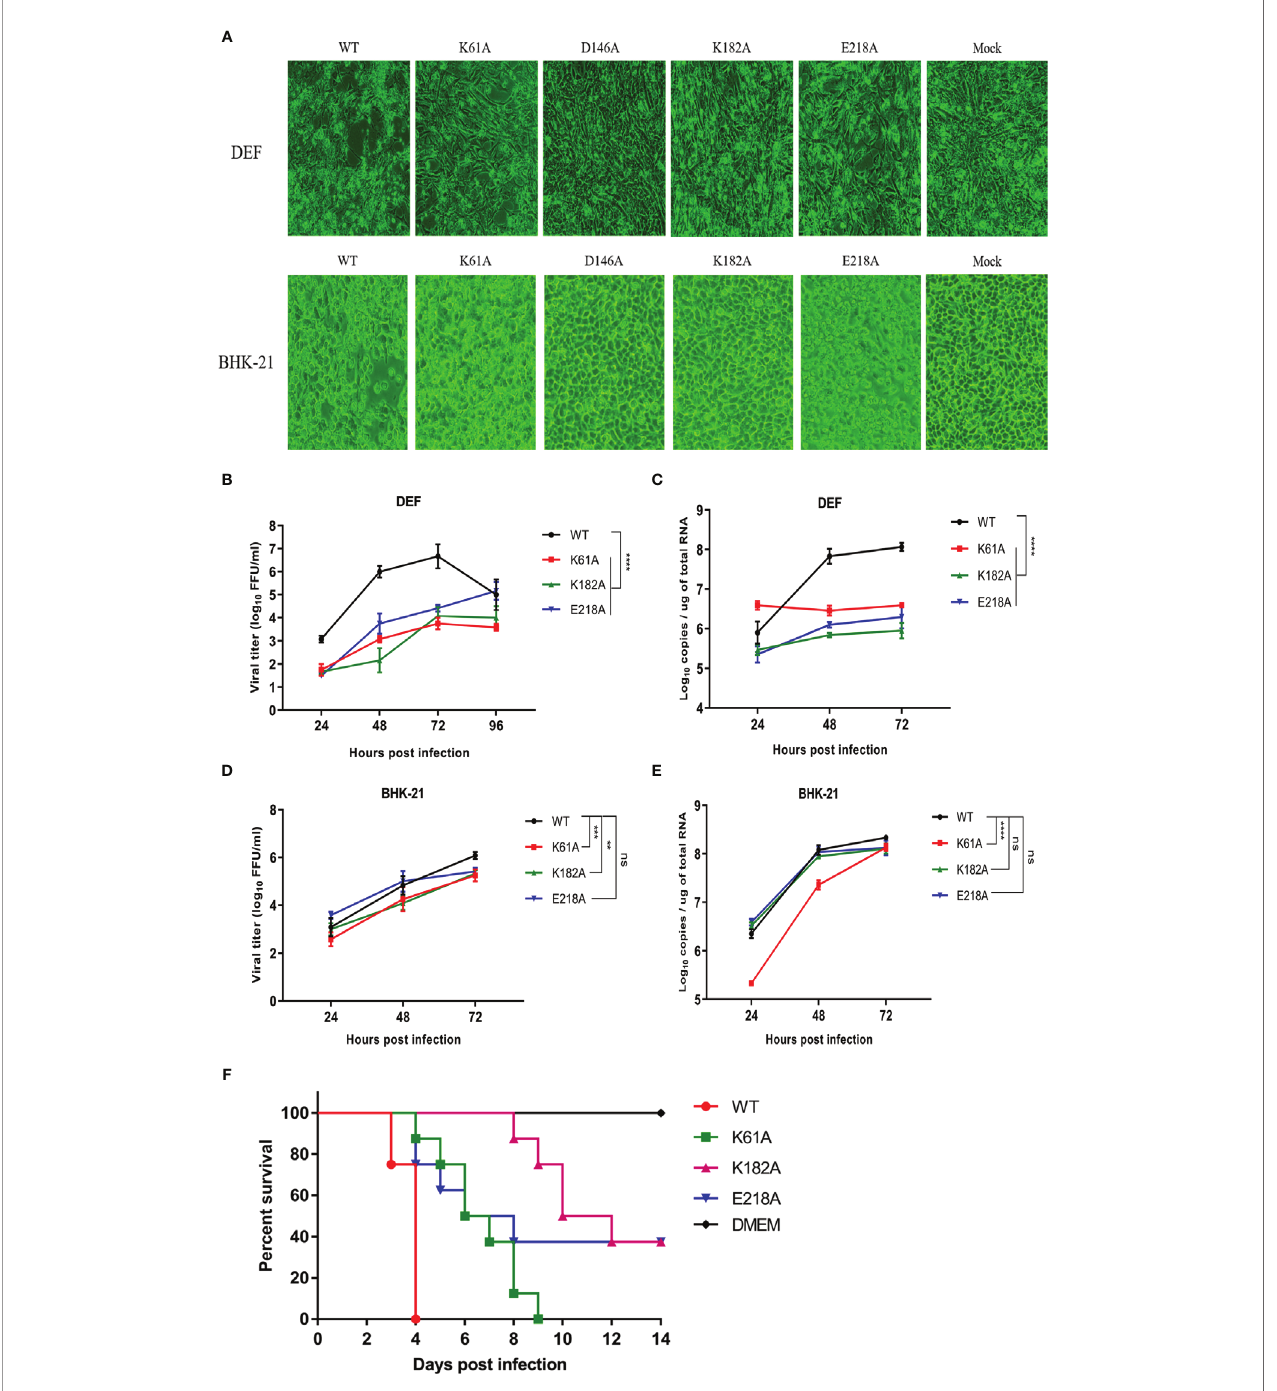
FIGURE 3 | Mutant TMUVs are attenuated in vitro . (A) Cytopathic effects of WT and mutant viruses in DEF and BHK-21 cells. Cells were infected with P1 viruses at a MOI of 0.01, and the extent of cytopathic changes was observed daily. The images were taken by post-infection day 4. (B – E) Growth kinetics of WT and mutant viruses in DEF (B, C) and BHK-21 (D, E) cells. Cells were infected with WT and mutant viruses at a MOI of 0.01. Viral titers and RNA copy numbers were measured at indicated times using fl uorescence formative unit (FFU) and absolute qPCR assays. Each of these was conducted with three parallel replicates. Bars show means ± SDs. **** P < 0.0001; *** P < 0.001; ** P < 0.01 (two-way ANOVA). (F) Virulence determination of WT and mutant viruses in duck embryos. 9-day-old embryonated duck eggs (n = 8) were infected by allantoic-cavity inoculation with 10 4 FFU of WT, K61A, K182A or E218A virus, respectively, while the mock-infection group received 100 ul of DMEM. ns, no signi fi